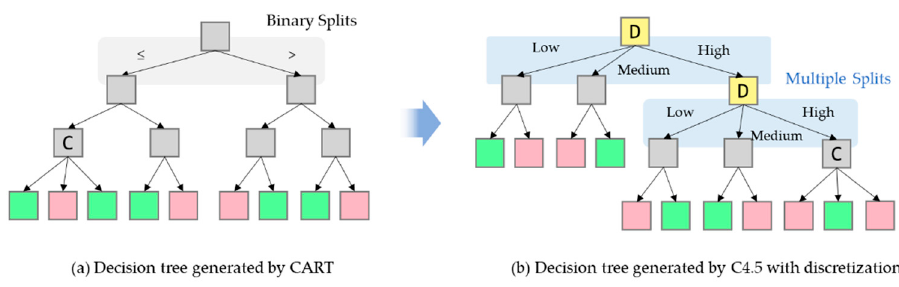
Figure 1. Illustration of a decision tree generated by CART and another tree generated by C4.5 with discretization. The discretized attributes are highlighted in yellow.